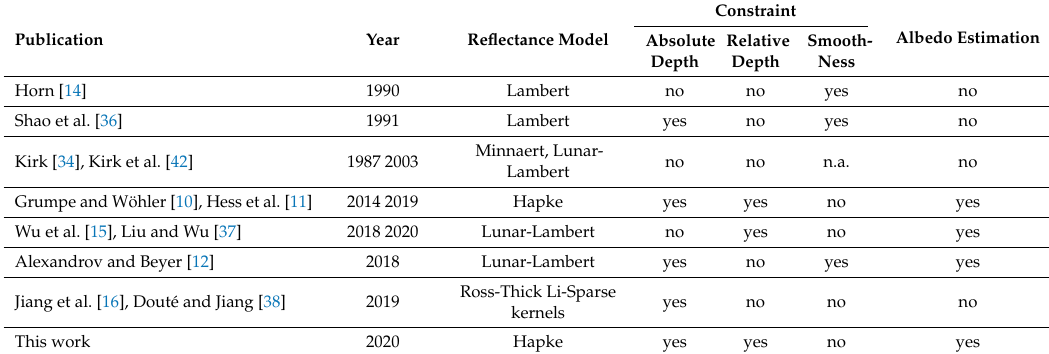
Table 2. Overview of different SfS